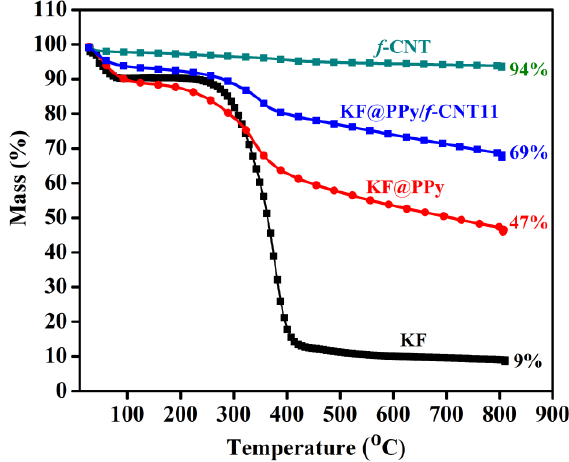
Figure 2. TGA curves of KF, KF@PPy, f -CNTs, and KF@PPy/ f -CNT11.